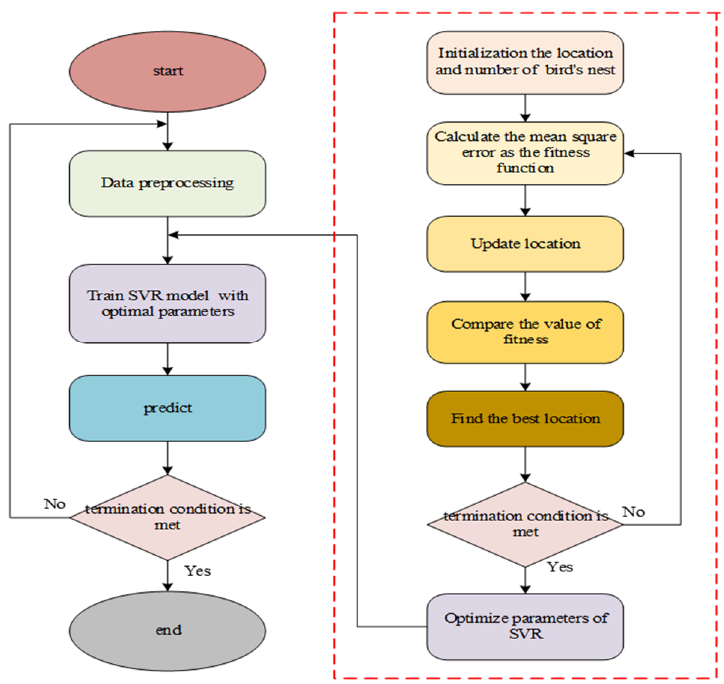
Figure 4. Flow chart of the support vector regression based on the cuckoo search (CS-SVR) algorithm.